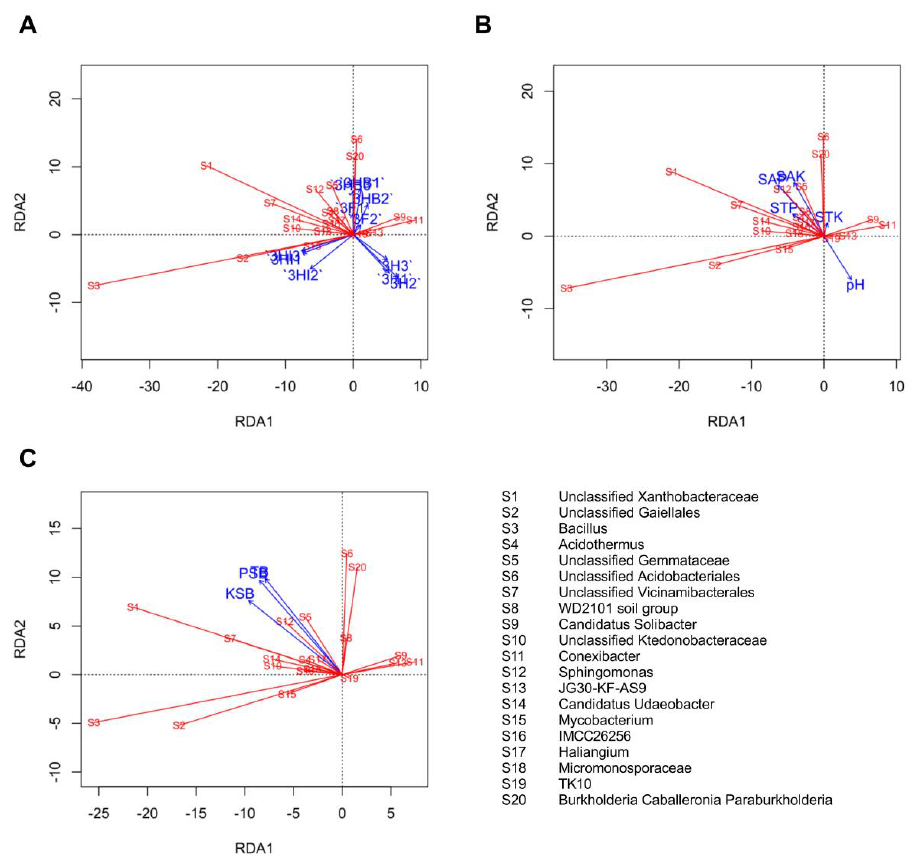
Figure 8. Redundancy analysis (RDA) of the correlation between the most abundant bacterial genera and ( A ), soil treatments; ( B ), soil P and K status; ( C ), soil culturable bacteria. Soil total phosphorus, STP; soil total K, STK, soil available P, SAP; soil available K, SAK; total bacteria, TB; P-solubilizing bacteria, PSB; K-solubilizing bacteria, KSB; Half-dose PK-fertilizer, 3H; half-dose PK-fertilizer and free-cell strain 40a, 3HI; half-dose PK-fertilizer and encapsulated strain 40a, 3HB; full-dose PK-fertilizer, 3F.